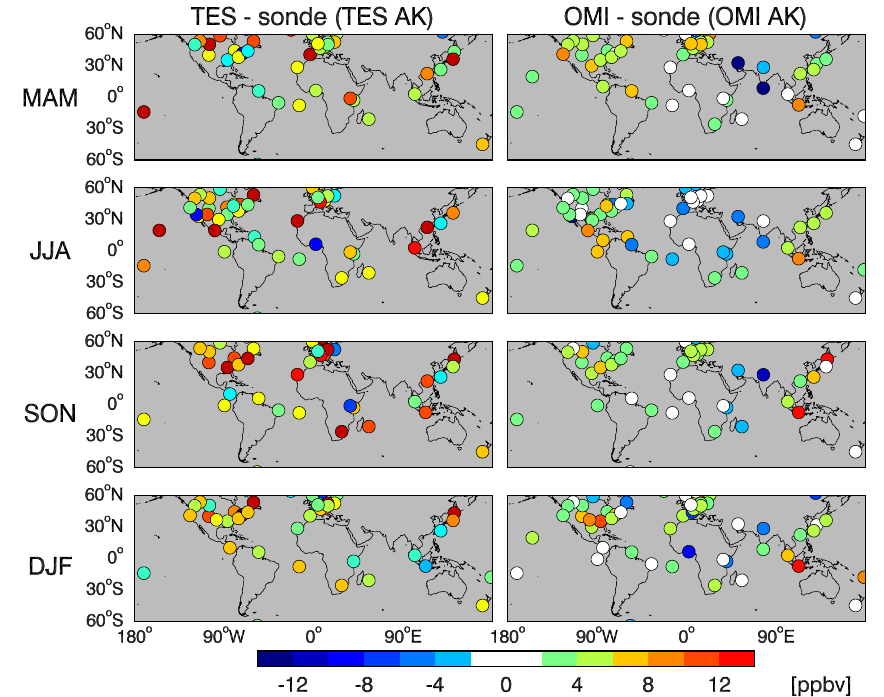
Fig. 5. TES and OMI ozone retrieval biases relative to ozonesondes in unit of ppbv at 500hPa averaged over the four seasons of 2005–2007. Each point represents the mean bias over a sonde launch site. Values are shown as differences between retrieved ozone concentrations and the ozonesonde data with averaging kernels applied. Red colors indicate a positive bias in the satellite data.